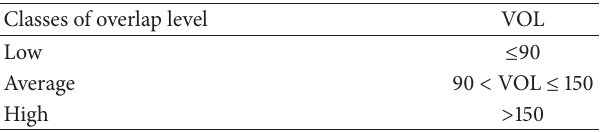
Algorithm 3: Boundary control mechanism. Table 2: Overlap level classification.